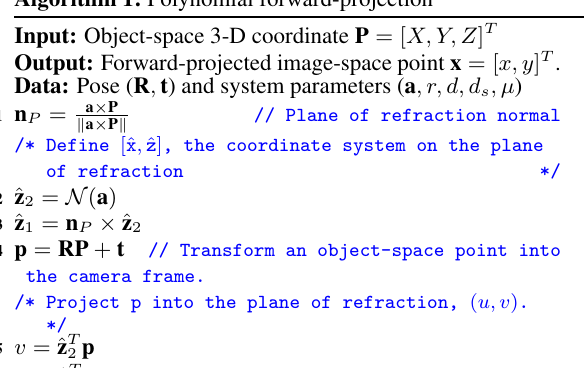
Figure 1: Refraction through a spherical surface where all refractions take place in the plane of refraction. Algorithm 1: Polynomial